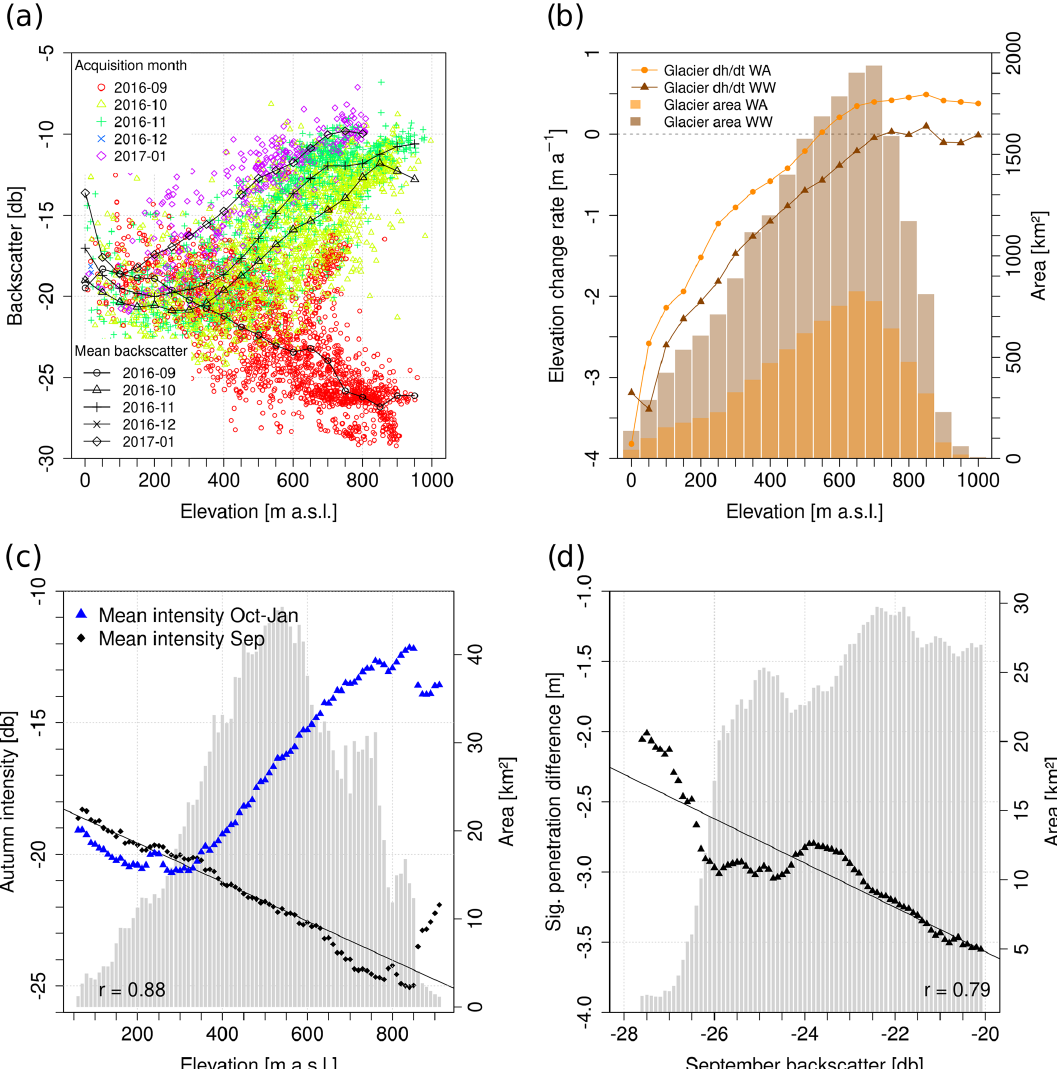
Figure 1. (a) Backscatter intensity of different TanDEM-X DEM acquisition months versus elevation on Novaya Zemlya. Black lines indicate average backscatter aggregated within 50m elevation bins. Point icons illustrate a random subset (5000 cells) of the 2016/17 DEM mosaic of Novaya Zemlya. In December 2016 (blue crosses), only a small glacier area at the northeastern coast was acquired. (b) Mean elevation change rates of DEM differences between winter 2010/11 and winter 2016/17 (WW; triangles) and winter 2010/11 and September 2016 (WA; dots) of all respective glacier areas. (c) Altitudinal distribution of mean backscatter intensity (aggregated in 10m elevation bins) of September and winter 2016/17 SAR data on overlapping glacier areas (i.e., areas which were acquired in September and winter 2016/17). (d) Differences in estimated signal penetration between September and winter 2016/17 (Sect. S3.1) versus mean backscatter intensity of September 2016 acquisitions on overlapping glacier areas (aggregated within 0.1dB backscatter intervals between − 20 and − 28dB). The linear correlations of mean September backscatter intensity and elevation (c) and mean difference in signal penetration depth and September backscatter intensity (d) are indicated as black solid